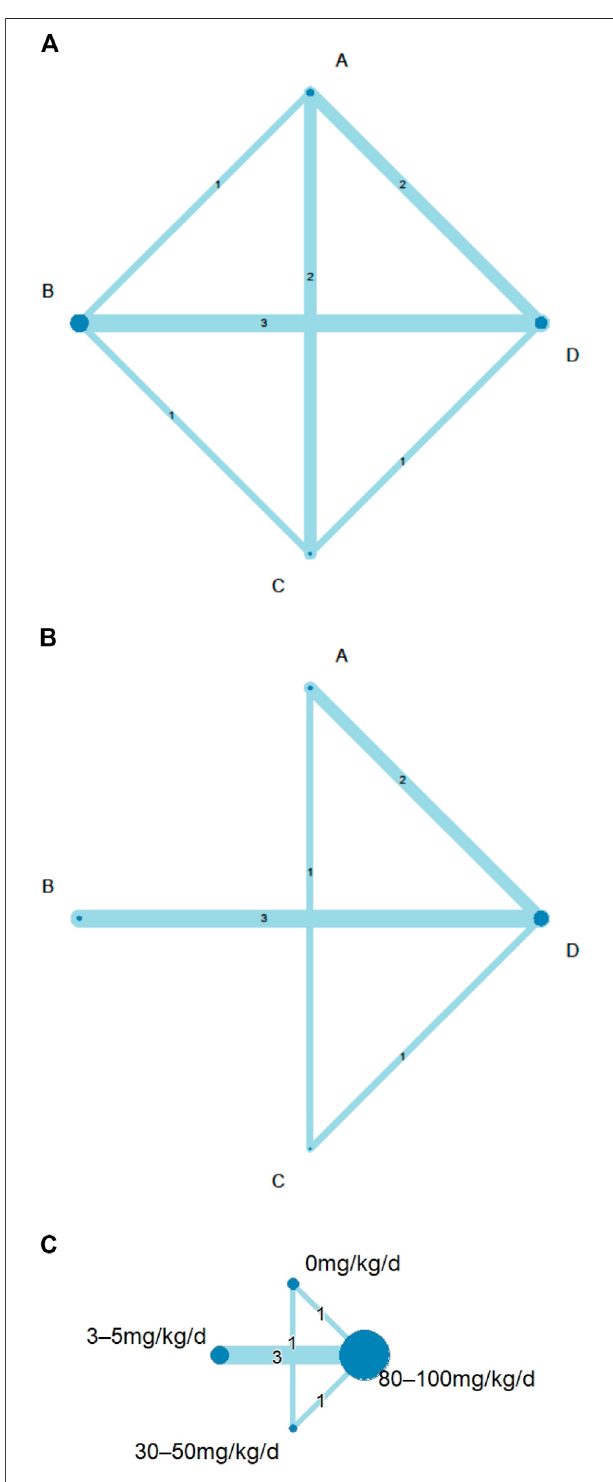
FIGURE 2 | Network geometry of eligible comparisons among different doses of aspirin for: (A) consistency analyses of coronary artery lesions (CAL) rate by node-split model; (B) intravenous immunoglobulin (IVIG) resistance rate; (C) length ofhospital stays. Network diagrams wereproduced with